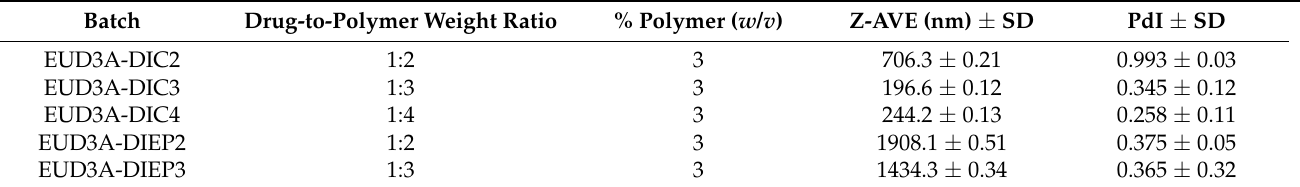
Table 2. Composition, mean size (Z-Ave) and polydispersity index (PdI) of DIC-loaded EUD NPs (EUD3A-DIC) and DIEP-loaded EUD NPs